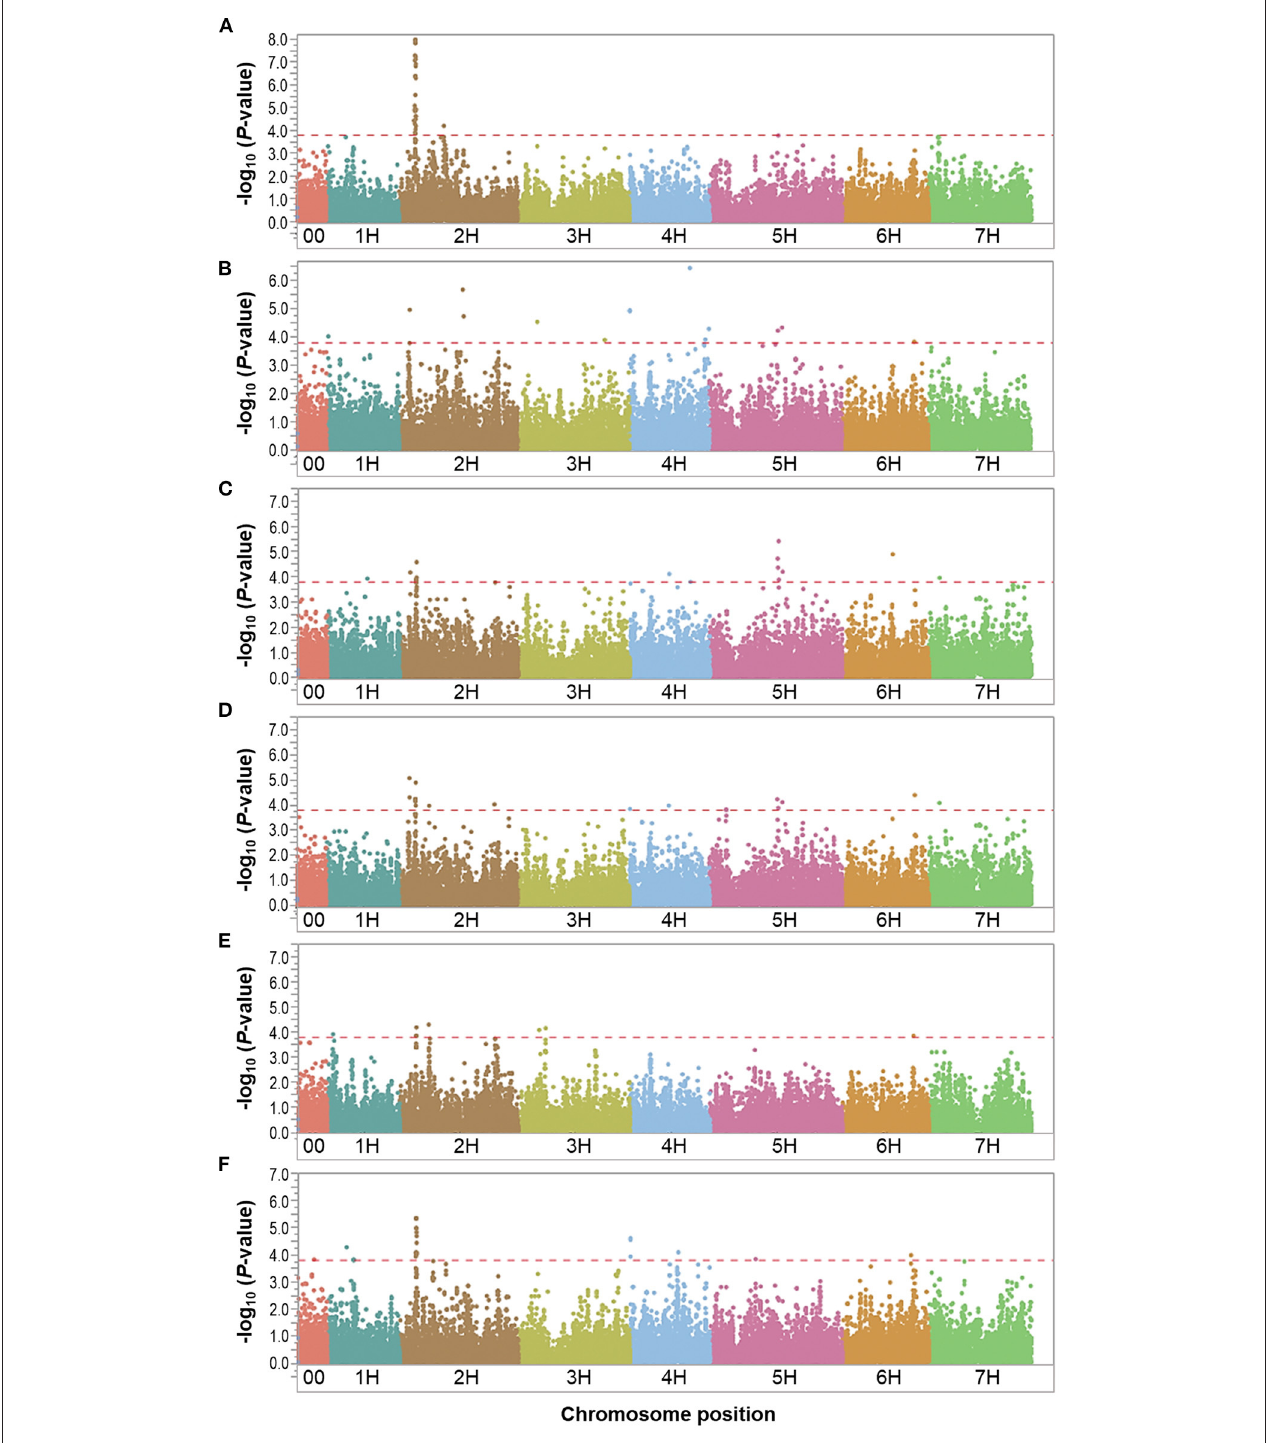
FIGURE 4 | Manhattan plots resulting from the SNP-based GWAS in waterlogging treatment under field conditions. Manhattan plots for Biomass (BIO), Spikes per plant (SP), Grains per plant (GP), Kernel weight per plant (GWP), Plant height (PH), and Waterlogging score (WLS) are shown in (A–F) , respectively, and the x-axis shows SNP loci along the seven barley chromosomes. The horizontal red line shows the genome-wide significance threshold P -value of 1.6 × 10 − 4 or –log 10 ( P -value) value of 3.8. GWAS was performed using the MLM (Q + K) model in JMP Genomics for the field traits.